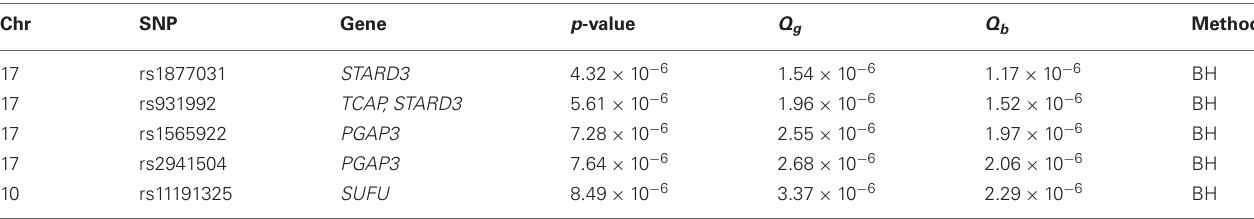
Q g and Q b are the eQTL weighted p-values based on the general weight and the binary weight, respectively. Using both weights result in the same set of SNPs.